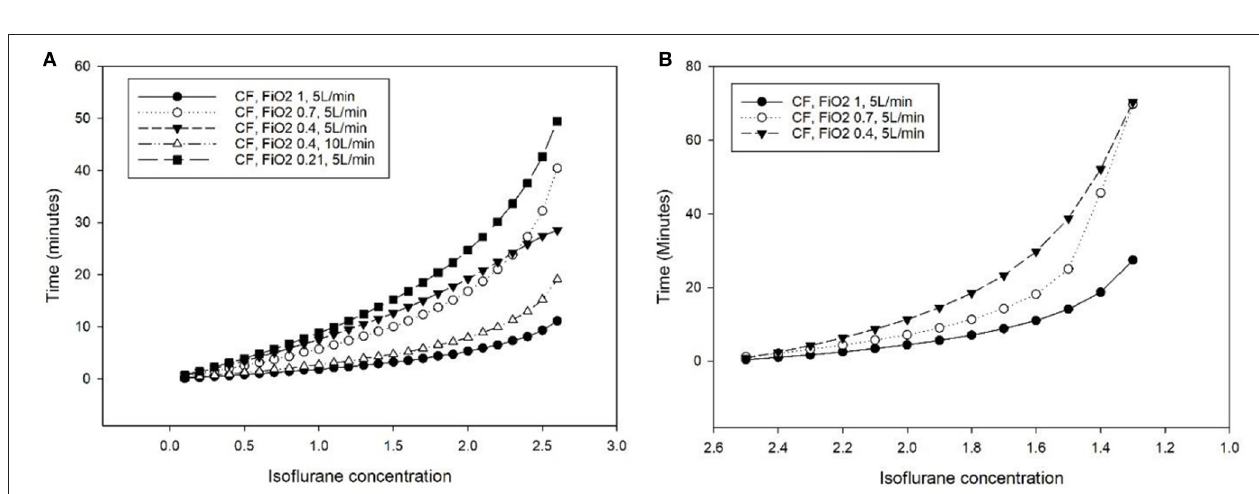
FIGURE 2 | Additional time (minutes) required to reach a specific isoflurane concentration in the breathing system of the Tafonius anesthesia machine during mechanical ventilation of a lung model (bag in a bottle) with a computer-driven flowmeter (CF) at different settings, compared to the use of a manual flowmeter at 5L minute − 1 . (A) Isoflurane increase from 0 to 3% (dial setting of a calibrated TEC 3 vaporizer). (B) Isoflurane decrease from 2.7 to 1%.